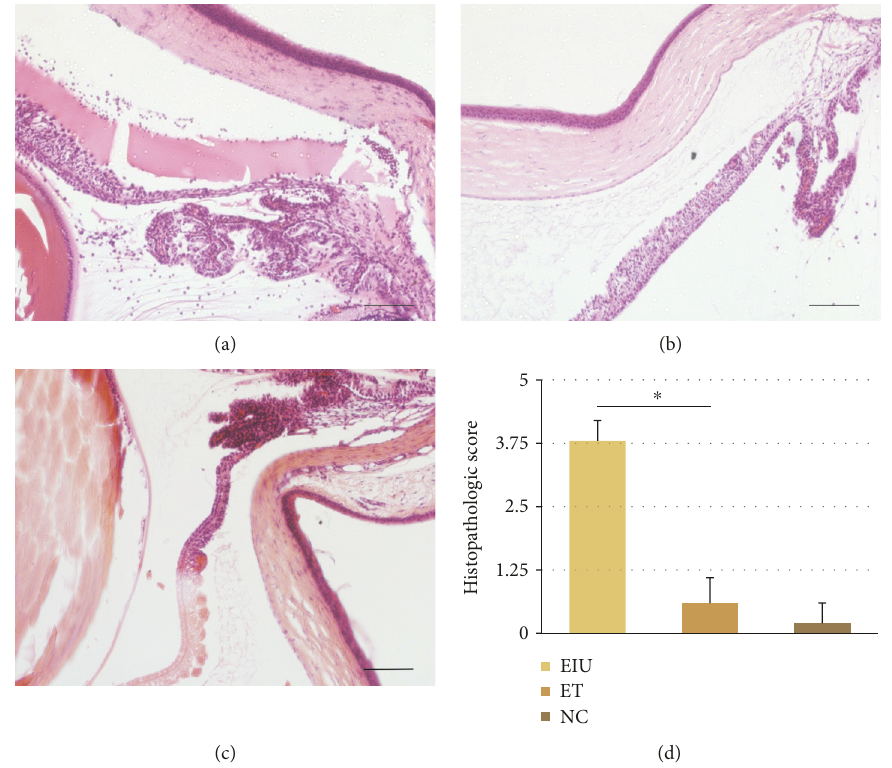
Figure 2: (a) The EIU group: heavy in fi ltration of in fl ammatory cells within the iris stroma, ciliary body, and the anterior chamber and in fl ammatory cells deposited on the corneal endothelium. (b) The ET group: only a few scattered in fl ammatory cells. (c) The NC group: no in fi ltrating cells. Scale bars: 200 μ m. (d) All data shown as mean ± standard deviation ( n = 20 , eye). ∗ p < 0 05 signi fi cantly di ff erent from EIU group.